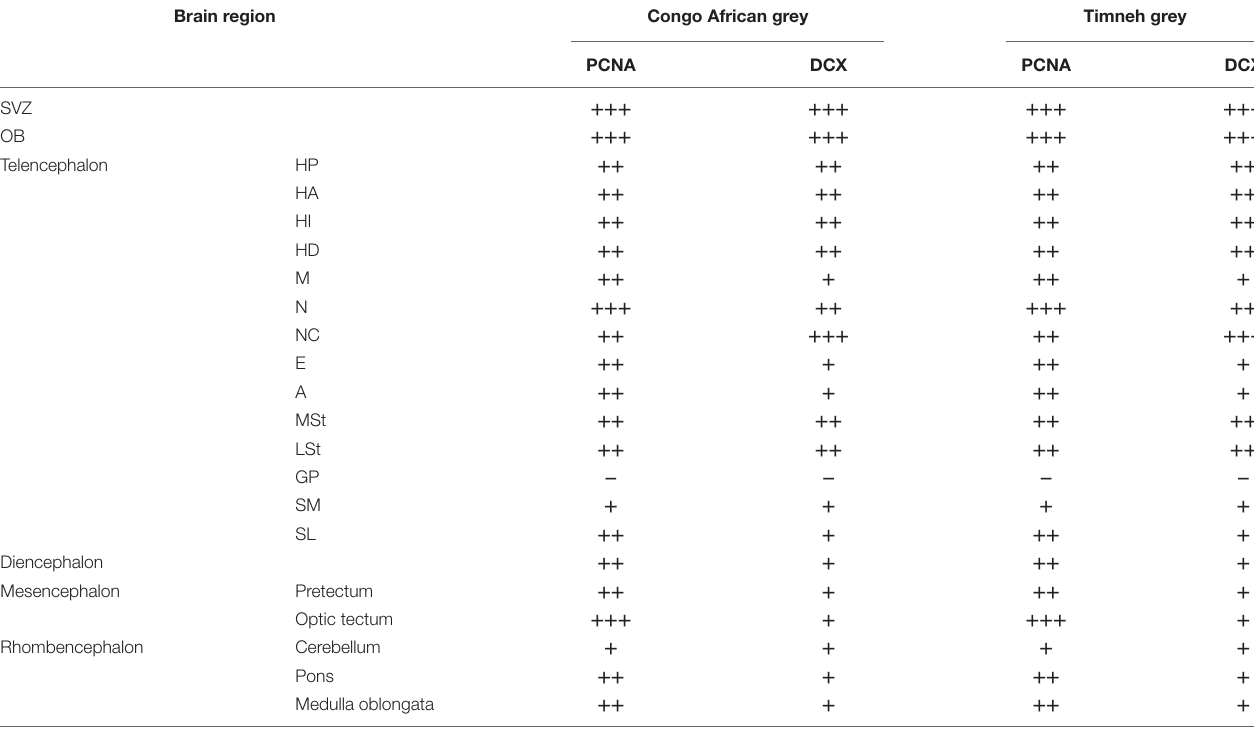
TABLE 1 | Summary of qualitative distribution and density of PCNA and DCX immunoreactive cells in the brain of the Congo African grey parrot and Timneh grey parrot. Brain